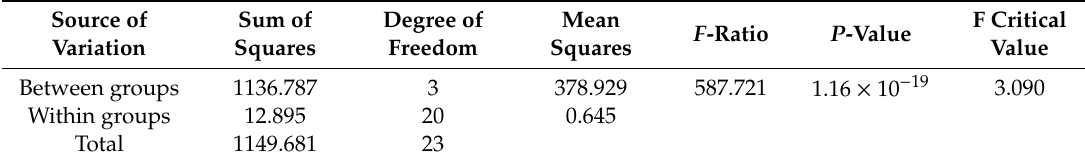
Table 5. One-way ANOVA for the ethanol concentration in the fermentation of hydrolysates produced by enzymatic hydrolysis of SPS in the presence of RQS and in synthetic media with directly added RQS. Source of Sum